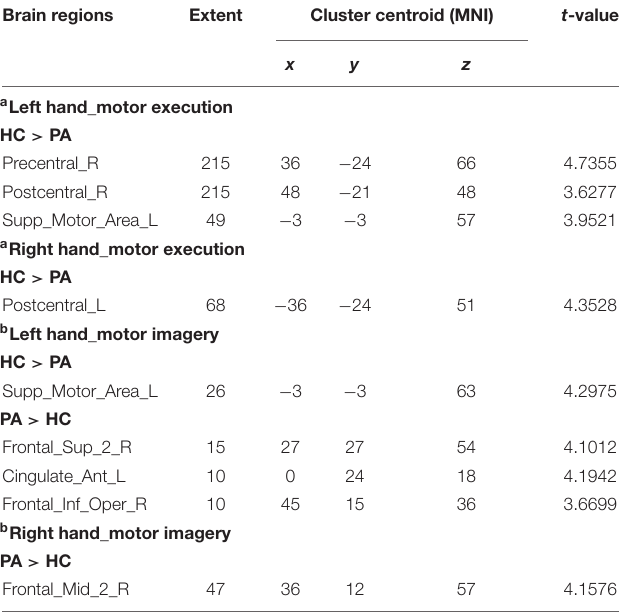
TABLE 3 | Differences in the brain active regions between PA and HC groups. Brain